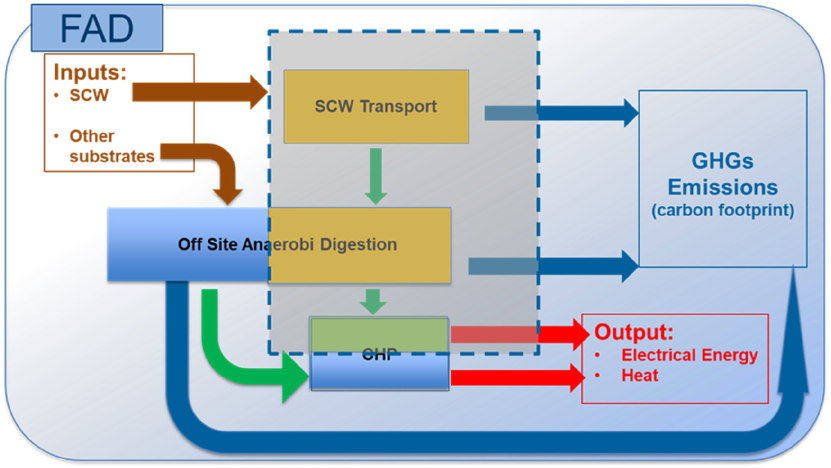
Figure 3. System boundaries of the reference scenario (system 1, FAD).